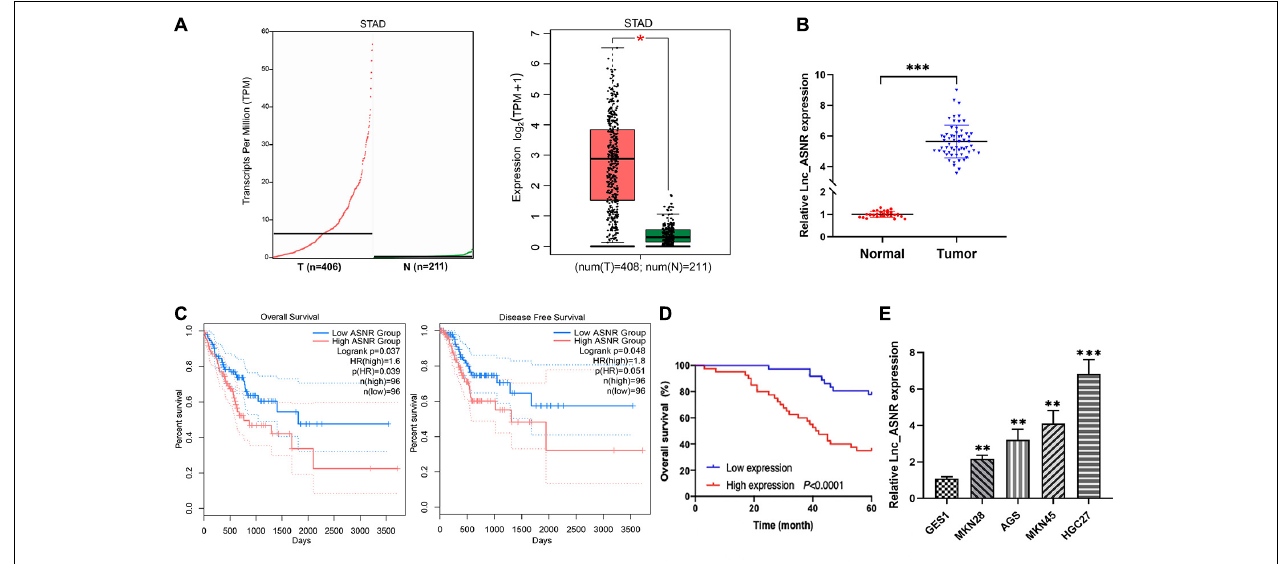
FIGURE 1 | High expression of Lnc_ASNR in GC tissue samples and cell lines. (A) Lnc_ASNR expression was analyzed by using GEPIA2 in GC tissues and normal tissues. (B) qRT-PCR was applied to indicate the expression of Lnc_ASNR in GC tissue samples and adjacent non-tumor tissue samples ( n = 76). (C) Overall survival and disease-free survival were analyzed using GEPIA2. (D) Kaplan–Meier analysis showed the relationship between Lnc_ASNR expression and overall survival time of GC patients. (E) qRT-PCR showed the expression of Lnc_ASNR in the normal cell line and GC cell lines. Error bars, mean ± SEM. * P < 0.05; ** P < 0.01; *** P <